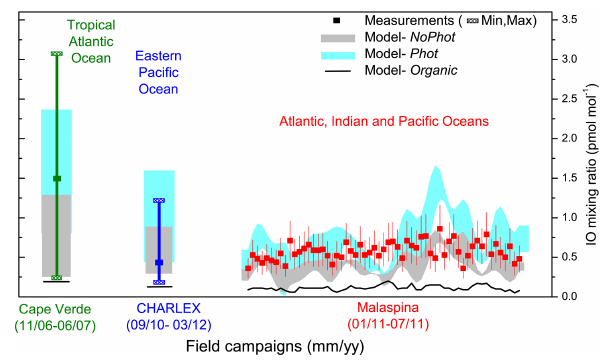
Figure 5. Measured and modelled IO mixing ratios in different field campaigns and oceans. For the two long-term campaigns on is- lands (Cape Verde in green and CHARLEX in blue), the mean day- time IO mixing ratio observed during the whole campaign period is given (filled squares) together with the minimum and maximum observed values (dashed rectangles) (Read et al., 2008; Mahajan et al., 2010; Jones et al., 2010). In the case of the Malaspina circum- navigation (in red), daytime averaged IO mixing ratios are provided (filled squares) along with their error (see also the Supplement). The shaded areas represent the standard deviation of the modelled fields for the no phot (gray) and phot (cyan) base scheme. For comparison purposes, the IO vmr modelled considering only the organic iodine precursors ( organic run) are also included (solid black